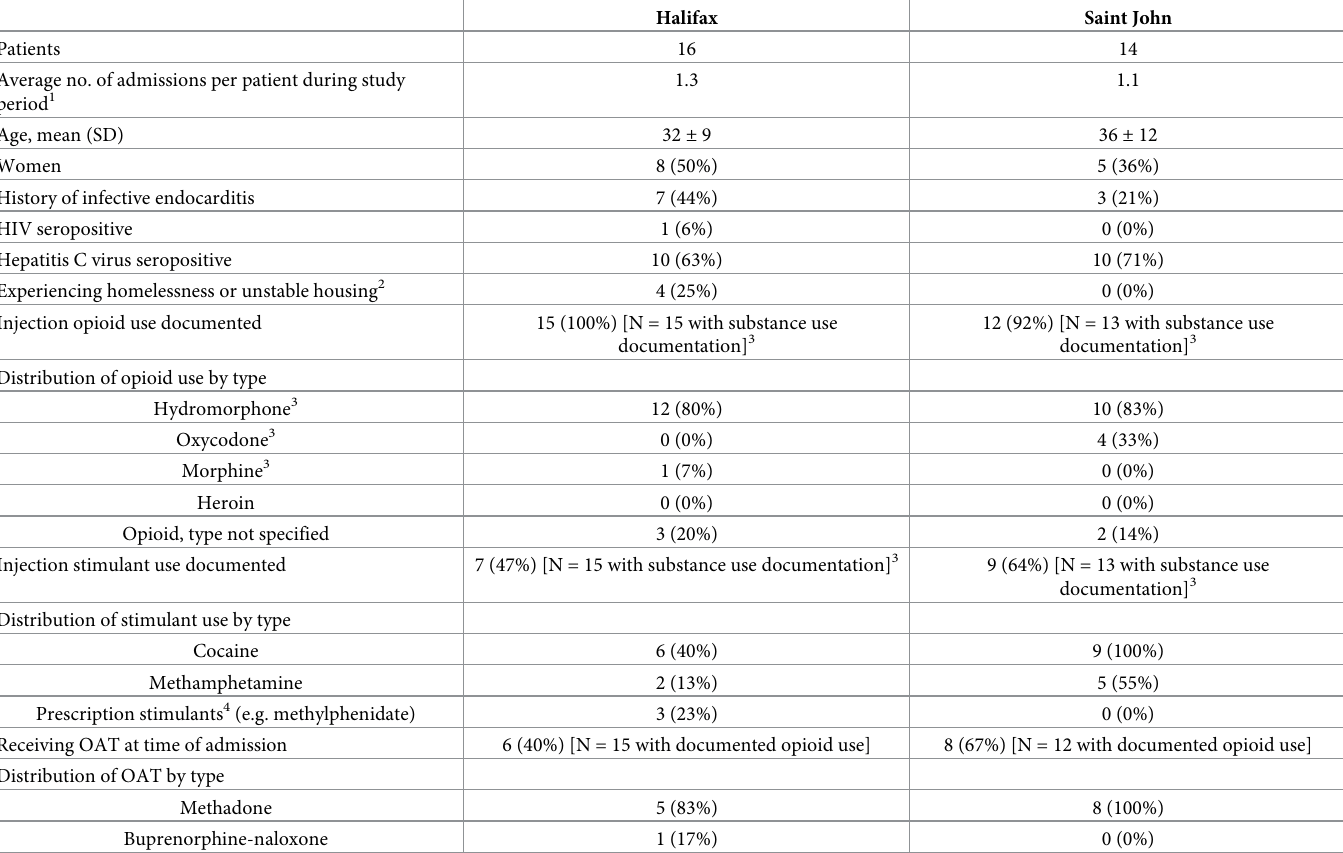
Table 1. Descriptive characteristics of patients during first episode of injection drug use-associated infective endocarditis in Halifax and Saint John, October 2015-March